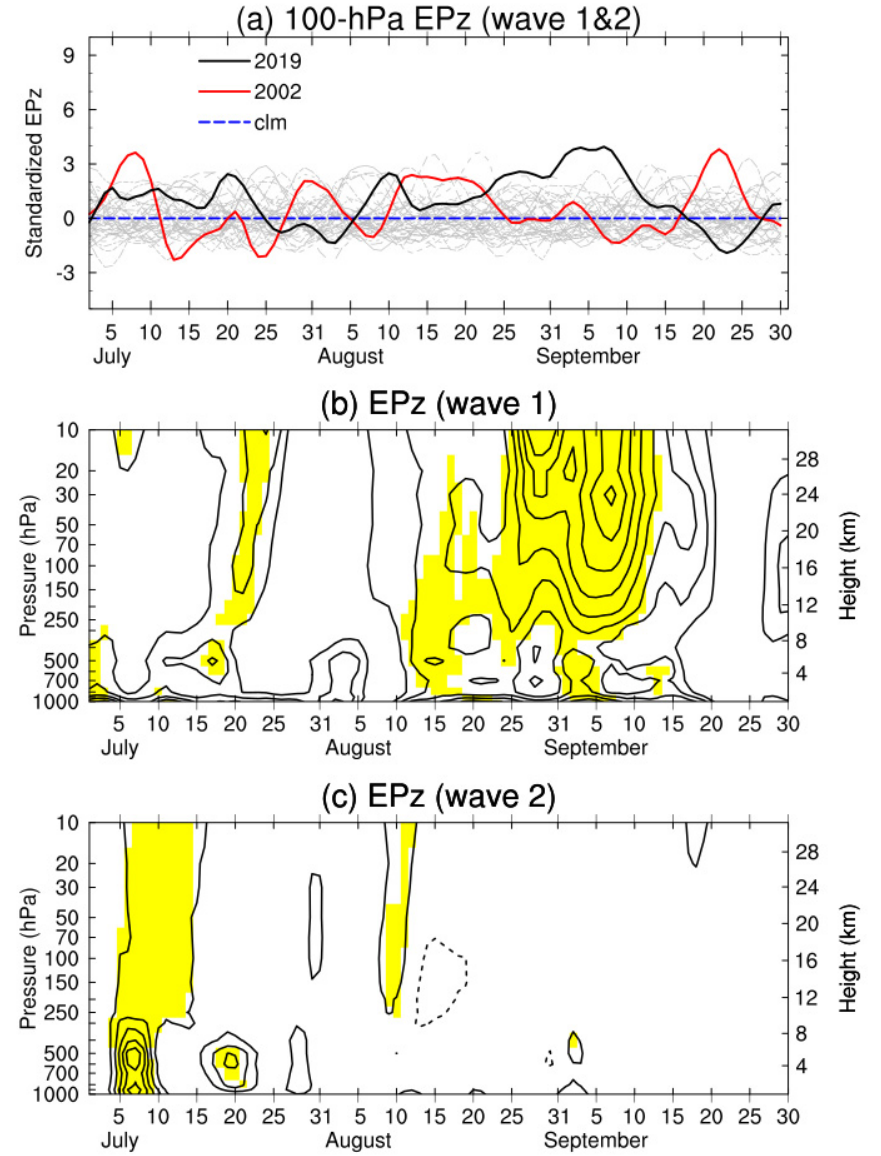
Figure 4. ( a ) Time series of the standardized EPz of wavenumbers 1–2 averaged over 55 ◦ S–65 ◦ S from 1 July to 30 September in 2002 (red), 2019 (black), other years (grey), and the climatology (blue). ( b ) Time-height sections of the EPz of zonal wavenumber 1 averaged over 55 ◦ S–65 ◦ S. ( c ) as in ( b ), but for zonal wavenumber 2. The EPz are weighted by the square root of 1000/pressure. The contour intervals in both ( b ) and ( c ) are 2 × 10 6 kg/s 2 . Yellow shadings denote the EPz exceeding the 95th percentile over each calendar day from July to September during 1979–2019.